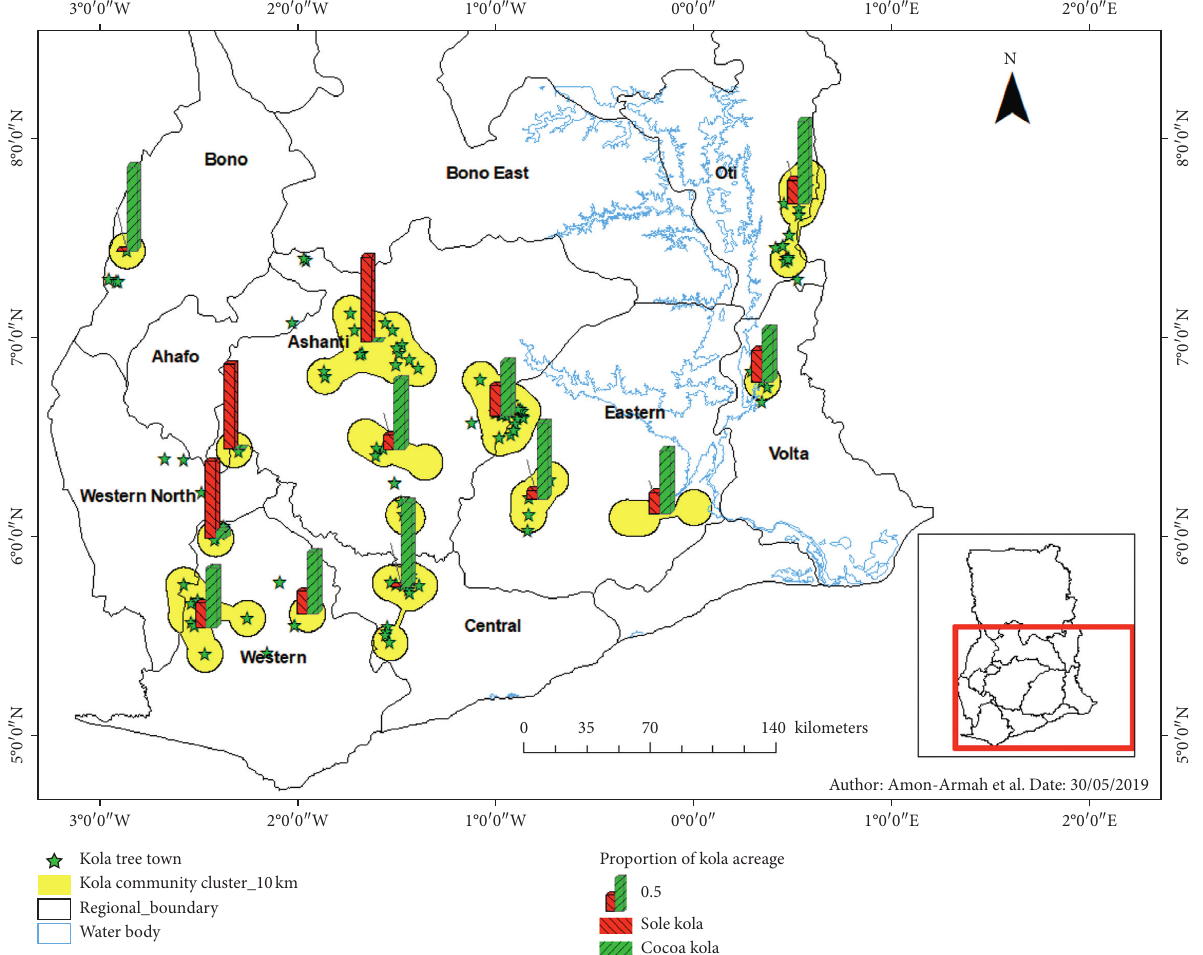
Figure 4: Map showing proportions of sole kola nut farms to cocoa-kola farms in clusters of 10km radius in the surveyed